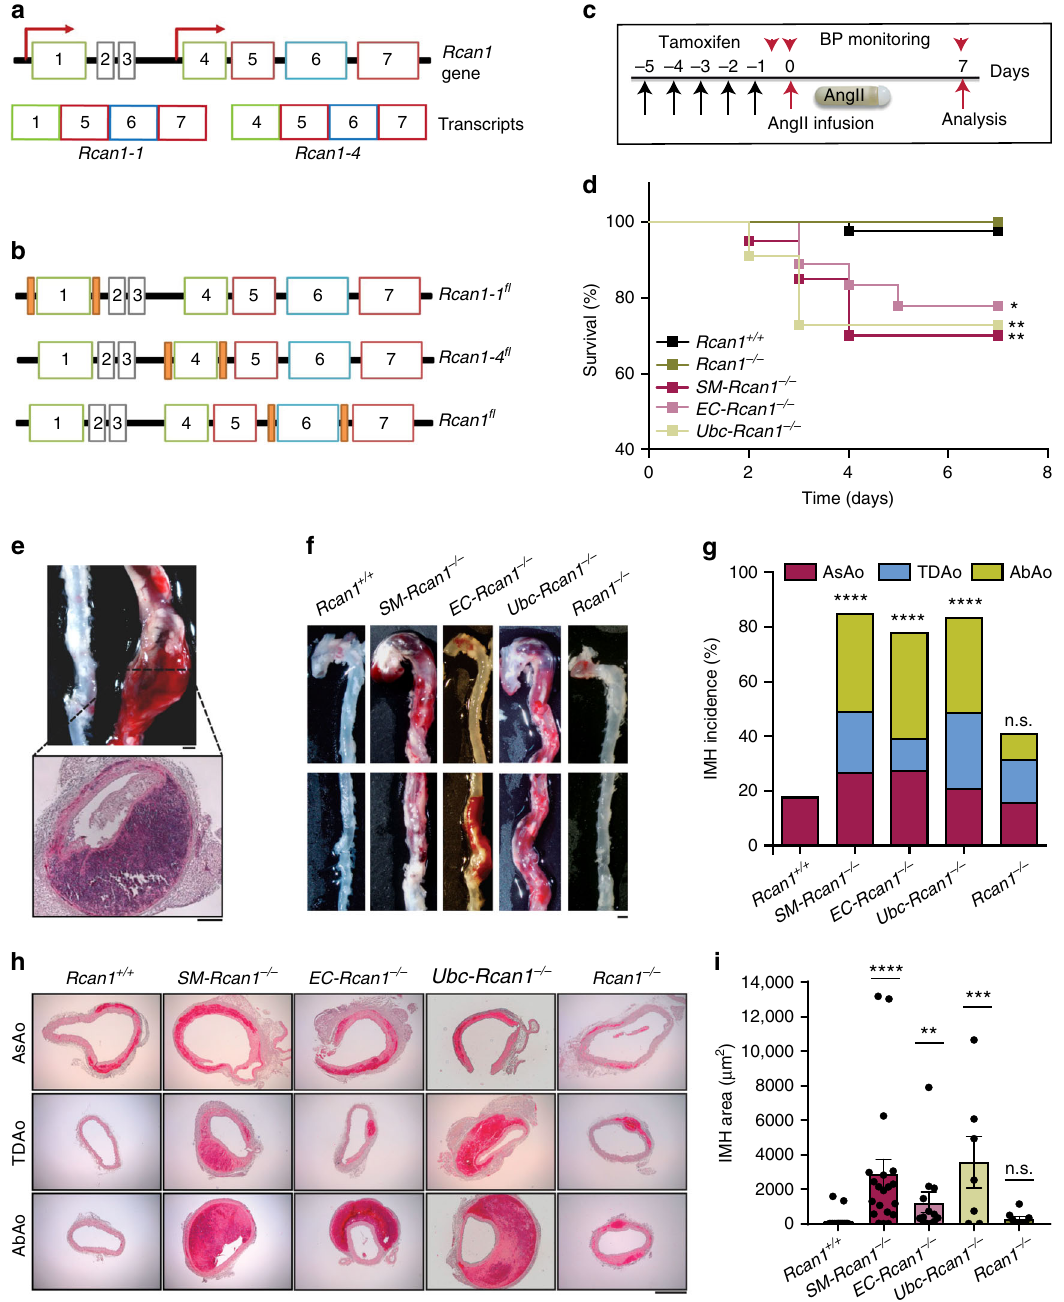
Fig. 1 Inducible Rcan1 deletion predisposes to aortic rupture and IMH. a Schematic representation of the Rcan1 locus and Rcan1 isoforms (Transcripts), indicating exons (boxes) and transcription initiation sites (arrows). b Relative position of LoxP sites (orange boxes) fl anking exon 1, 4, or 6 in Rcan1-1 fl / fl , Rcan1-4 fl / fl , or Rcan1 fl / fl , respectively. c Experimental design. Mice were treated with tamoxifen for 5 consecutive days (black arrows) before the implantation of osmotic minipumps for AngII infusion (1 μ g kg − 1 min − 1 ). Mice were monitored for BP (red arrowheads) and euthanized after 7 days.